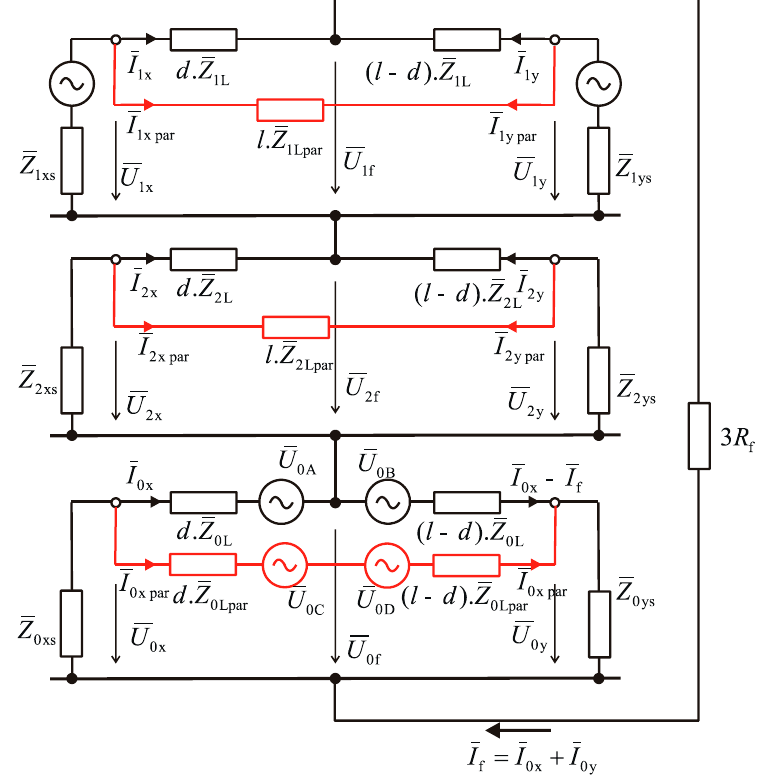
Figure 2. The equivalent circuit for parallel-operated transmission lines.